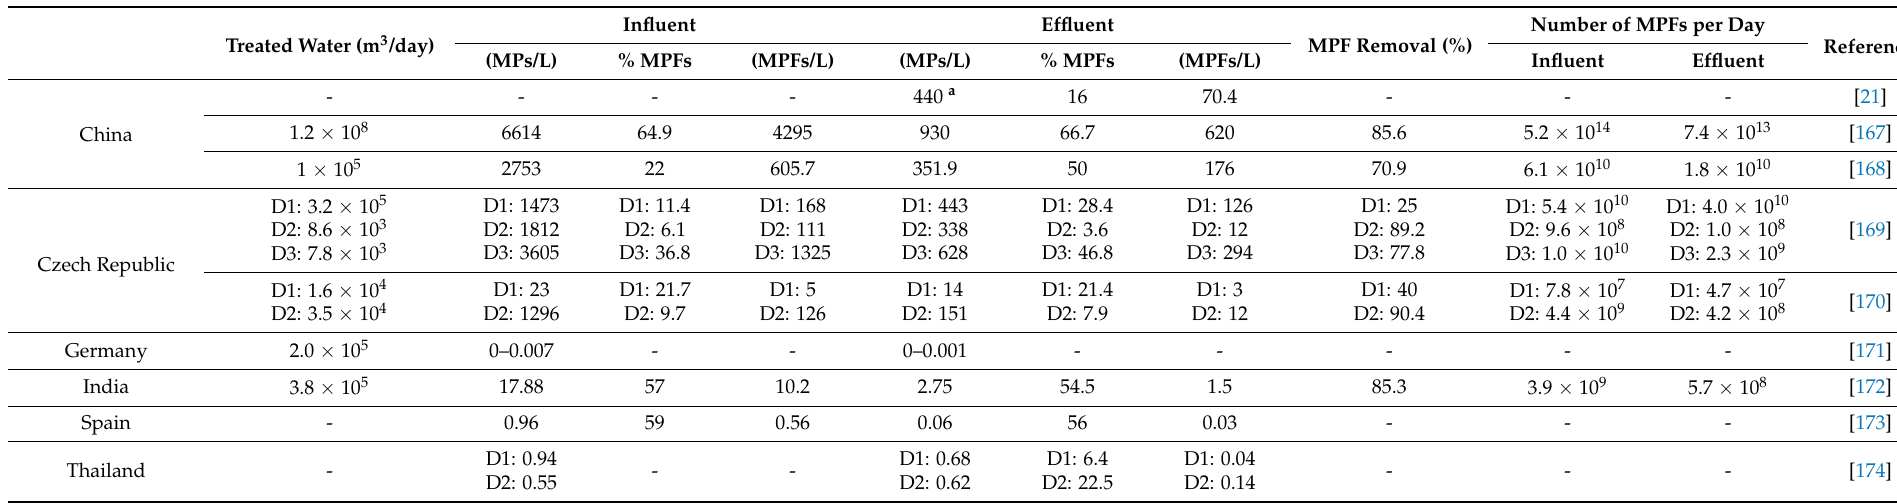
Table 3. Overview of the incidence of MPs and microfibres in DWTPs. “D” followed by a number refers to different DWTPs analysed in the cited reference. Treated Water (m 3